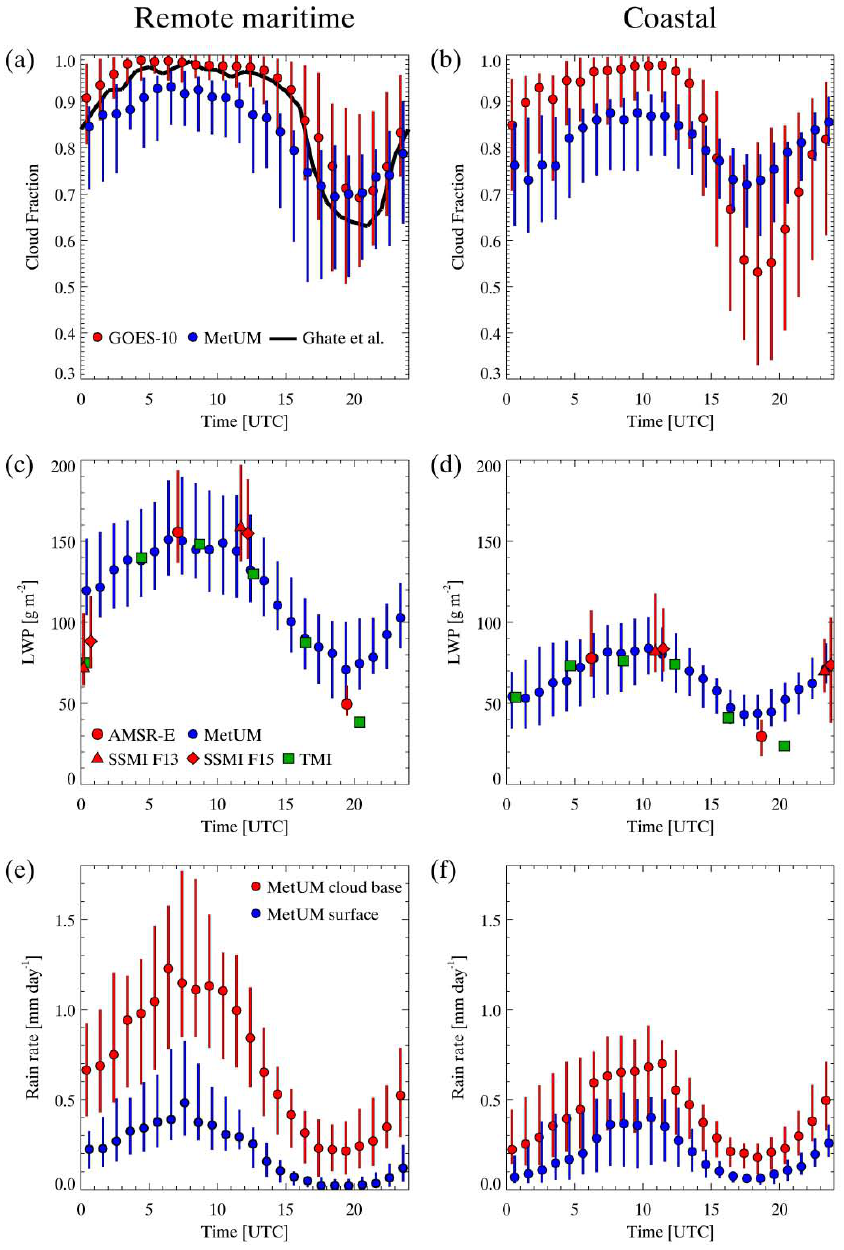
Fig. 8. Diurnal cycle of low cloud fraction, LWP and cloud base and surface rain rate for the period 14 October to 19 November 2008. Panels (a) , (c) and (e) are representative of a remote maritime region (18–22 ◦ S, 83–87 ◦ W) and panels (b) , (d) and (f) a coastal region (18–22 ◦ S, 70.5–74 ◦ W). The bars span the interquartile range and the median is shown by filled symbols. A mean 2001 to 2005 October to November climatology of cloud fraction from the STRATUS buoy (Ghate et al., 2009) is also shown in panel (a) . For the TMI LWP data only the mean value is shown due to lower sampling